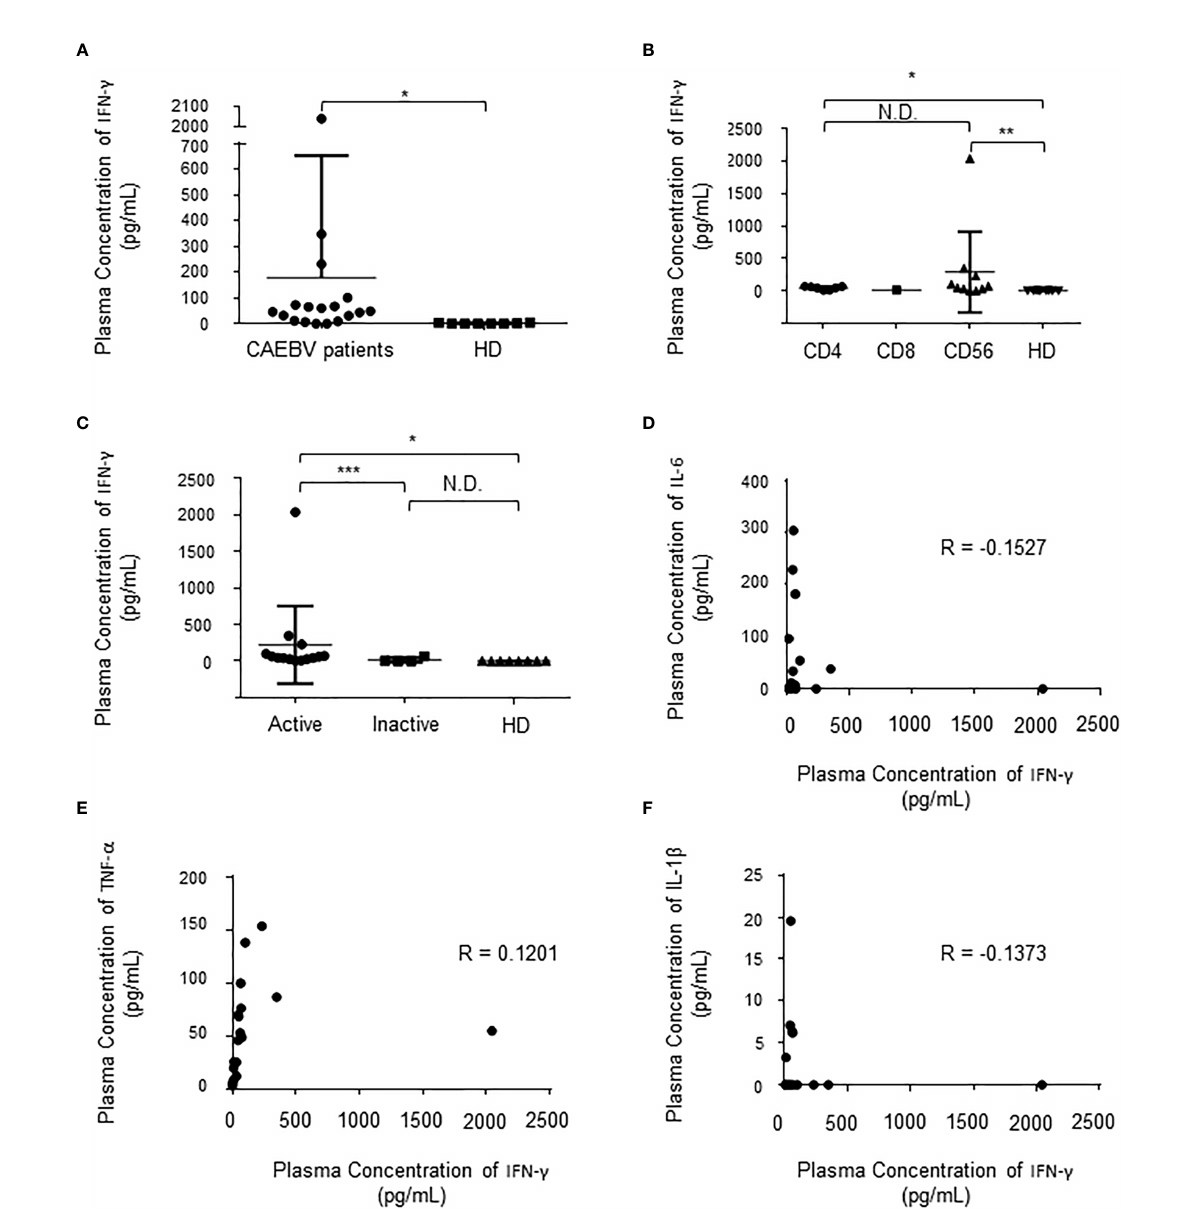
FIGURE 1 The plasma concentration of IFN- g in sCAEBV patients. (A) . The concentration in sCAEBV patients and healthy donors. Signi fi cant difference is indicated as * for p < 0.001 between the patients and the healthy donors. HD: healthy donors. (B) . The concentrations by EBV-infected cell types. Signi fi cant differences are indicated as * for p < 0.001 and ** for p < 0.01. N.D: no difference. HD: healthy donors. (C) . The concentrations by disease activity. Signi fi cant differences are indicated as * for p < 0.001 and *** for p < 0.05. N.D: no difference. HD: healthy donors. (D – F) . The correlation between the plasma concentration of IFN- g and the plasma concentration of IL-6 (D) , TNF- a (E) , and IL-1 b (F) . R: correlation coef fi